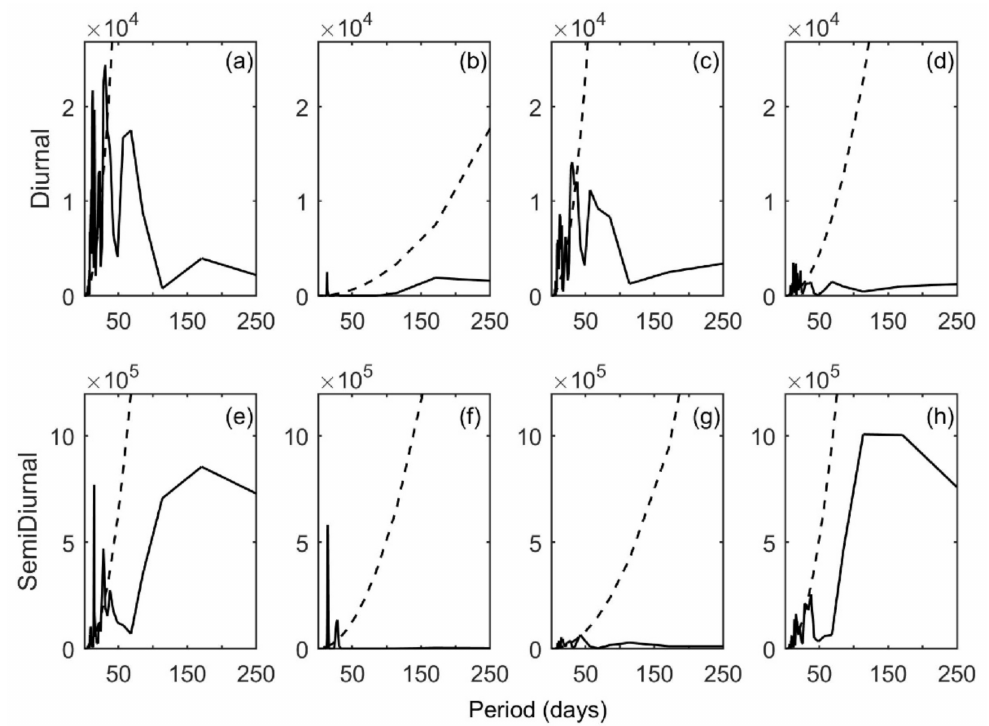
Figure 8. Power spectrum density of the depth-averaged HKEs of diurnal ( a ) and semidiurnal ( e ) currents and their coherent component ( b , f ), incoherent component ( c , g ) and cross-term ( d , h ). The dashed line represents the 95% confidence